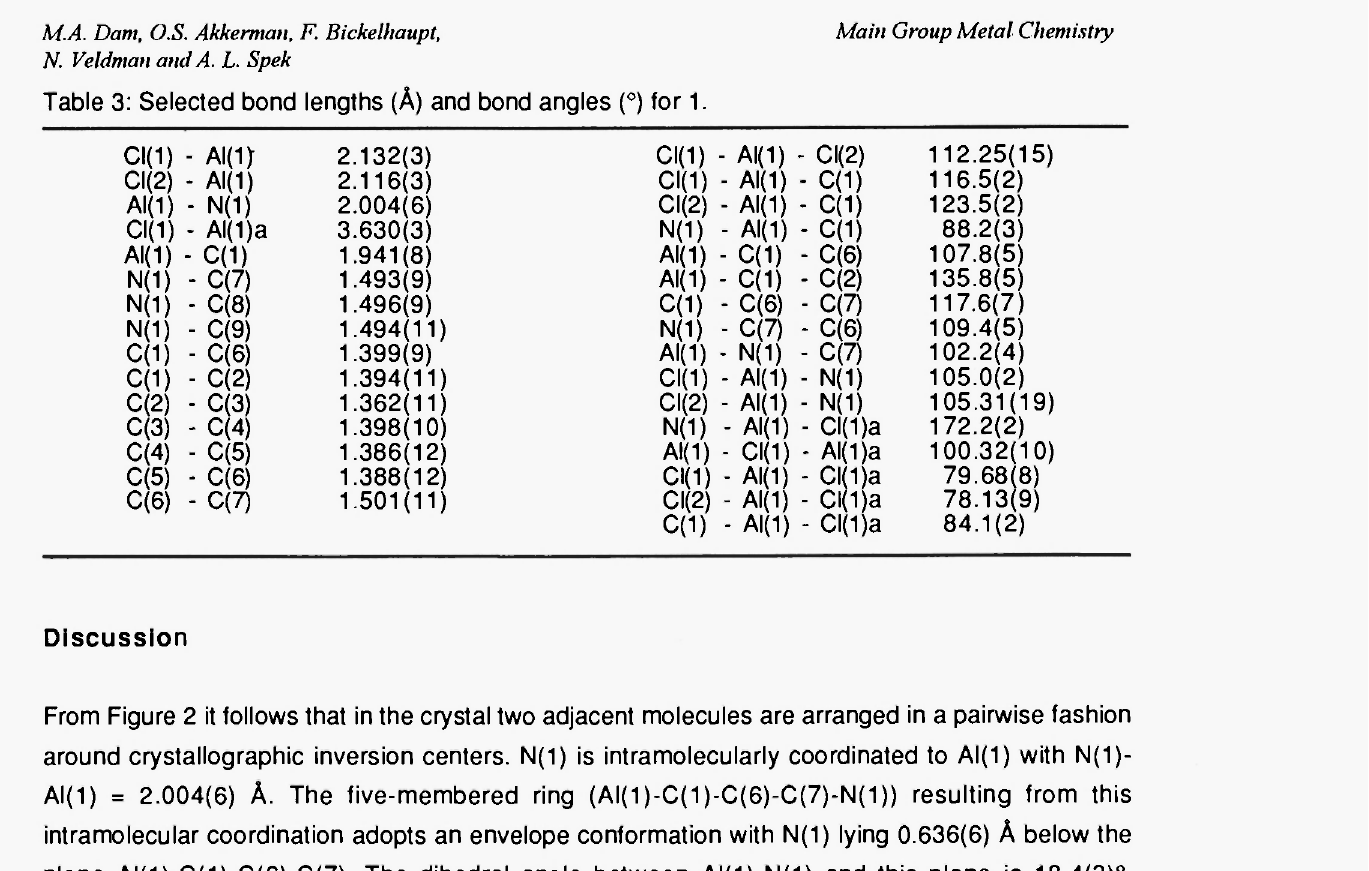
Table 3: Selected bond lengths (Ä) and bond angles (°) for